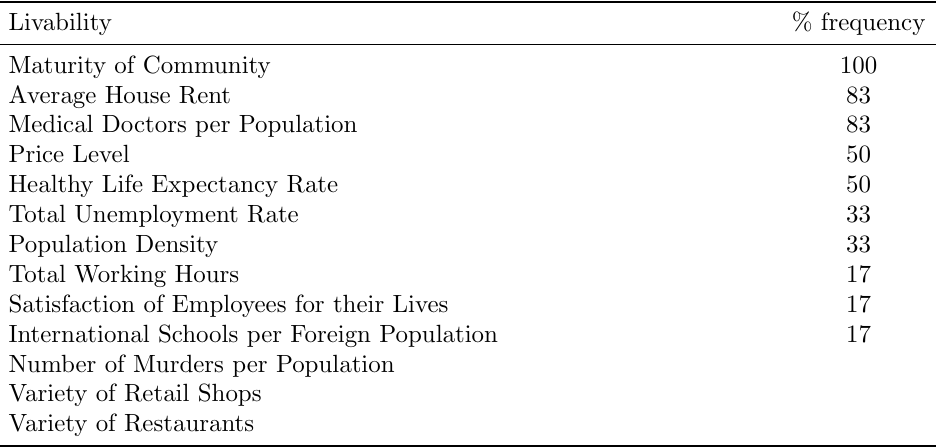
Table A.2: Frequency scores of the sub-sub factors of